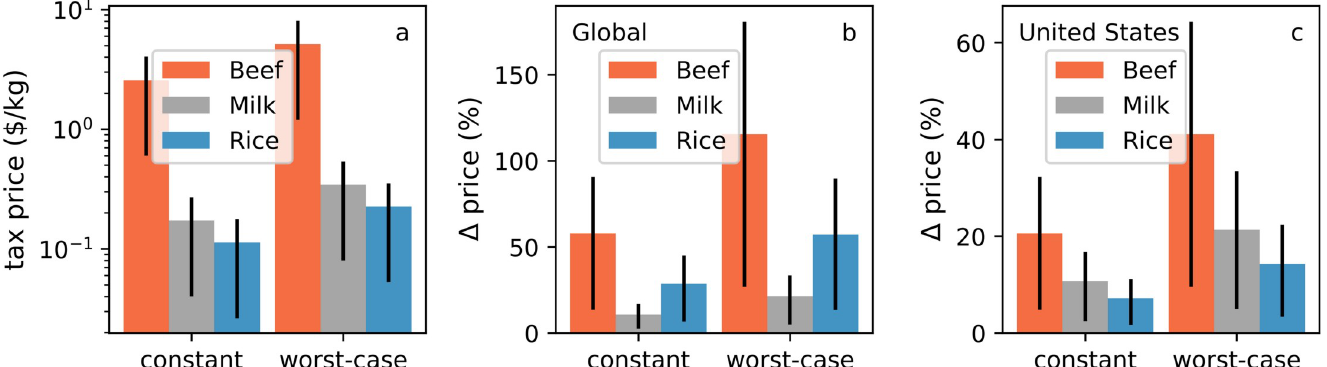
Fig 5. Tax-driven increase in price of agricultural commodities. a) Mean absolute price increase of agricultural products (beef, milk, and rice) due to the introduction of a tax on non-CO 2 agricultural emissions. b) Relative price increase compared to their current average retail price globally. c) Relative price increase compared to their current average retail price in the United States. Error bars denote the price uncertainty stemming from CDR cost uncertainty in the range of $35- 235/tCO 2